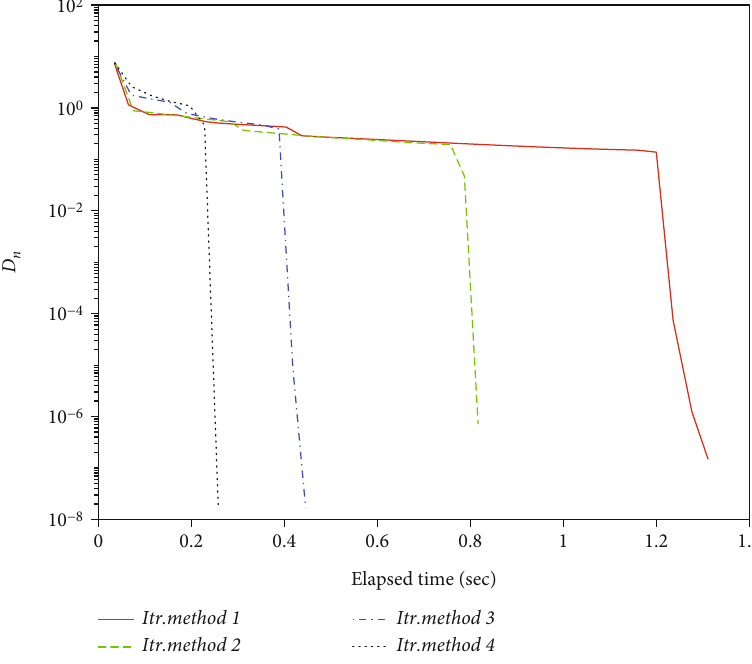
= ð 2, − 3, 5, 9, − 5 Þ T : 0